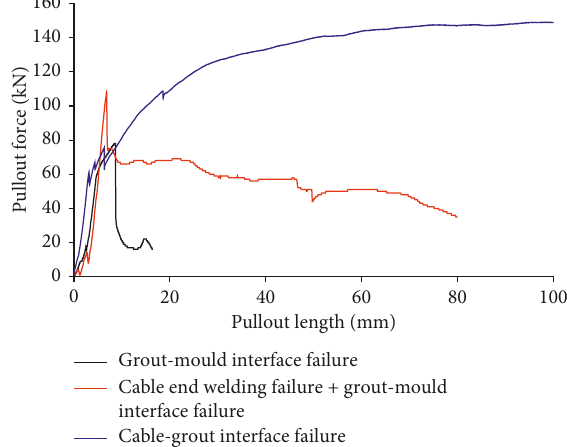
Figure 11: Load transfer performance of the cable bolt in DEPTof different failure